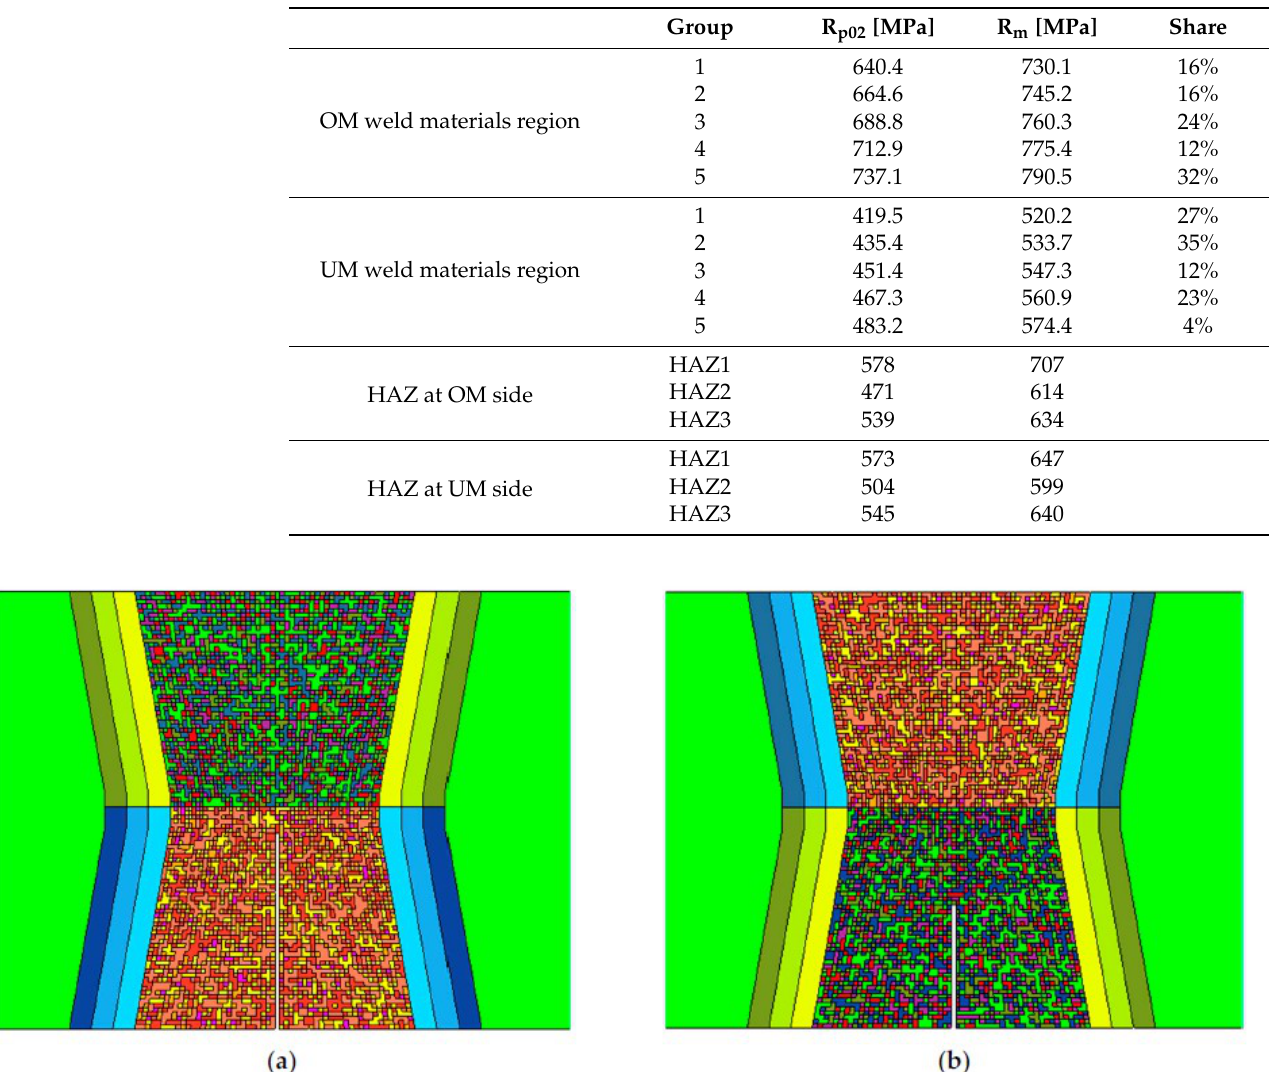
Table 6. Groups of mechanical properties used in FEM analysis.